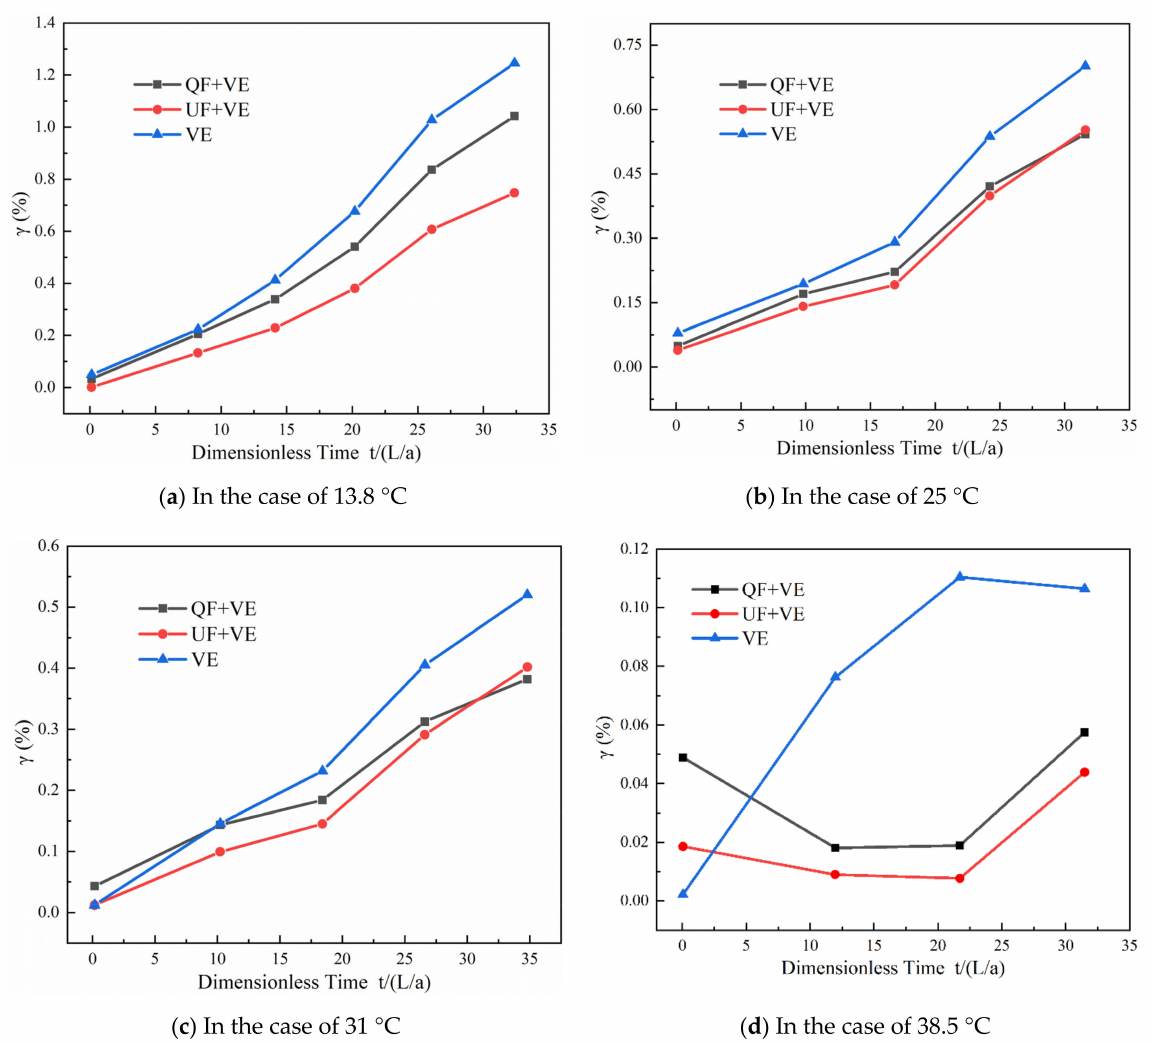
Figure 11. Comparison of the contributions of QF, UF, and VE components: ( a ) 13.8 ◦ C; ( b ) 25 ◦ C; ( c ) 31 ◦ C; ( d ) 38.5 ◦